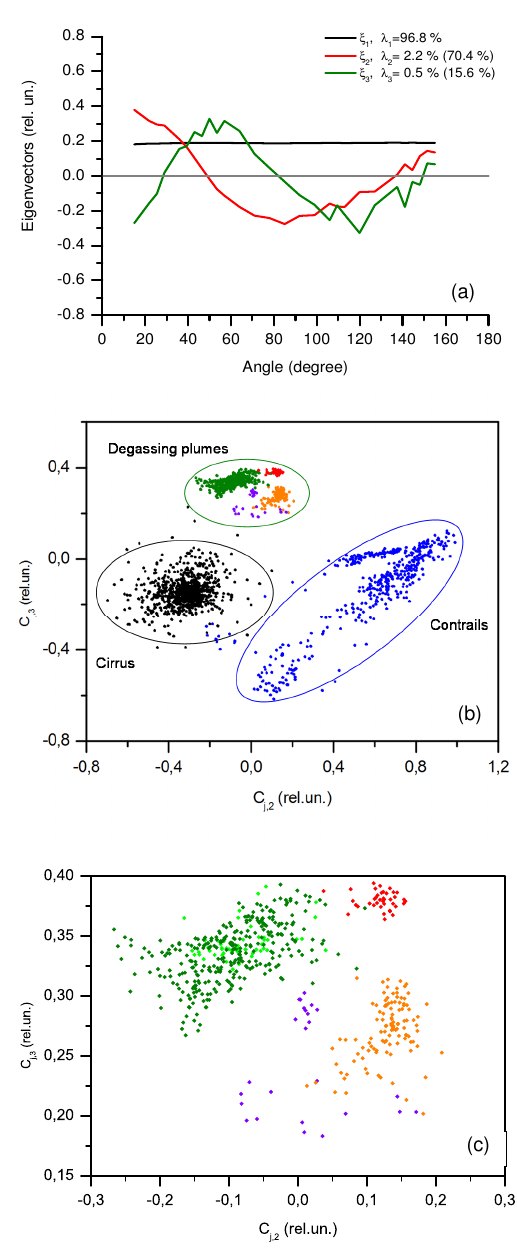
Figure 3. (a) Results of the principal component analysis. First three eigenvectors ( ξ l stand for ξ l ) of the angular-scattering intensi- ties (ASI) of the correlation matrix vs. measured scattering angles. Values of the first three normalized eigenvalues λ l of the eigenvec- tors and the remaining variability are also displayed. (b) Expansion coefficient diagram: third coefficient vs. second coefficient. Black points for cirrus clouds, blue points for contrails, olive points for the Northeast Crater plume, violet points for Stromboli, orange points for BNa, and red points for BNb crater plumes. (c) Same as (b) but with the focus of attention on the degassing plumes. Green points for NECa and olive points for NECb crater